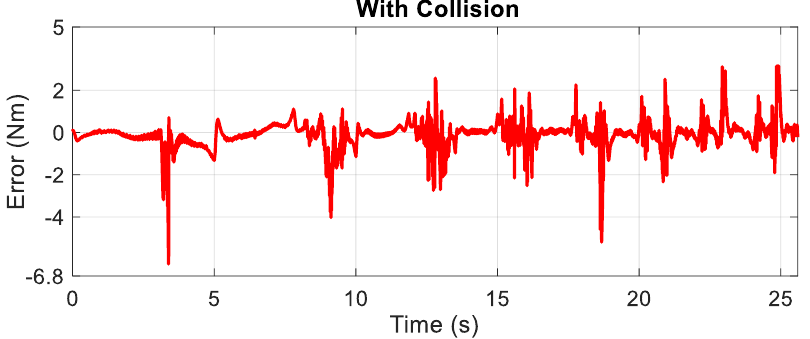
Figure 8. The approximating error calculated by subtracting the estimated external joint torque by NARXNN from the provided torque of KRC, in the case of a collision.